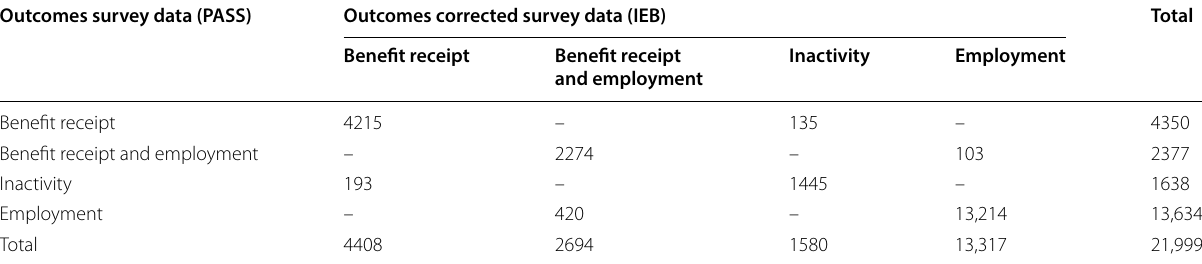
Source: PASS_0614_v1 & LHG V08.01.00 –